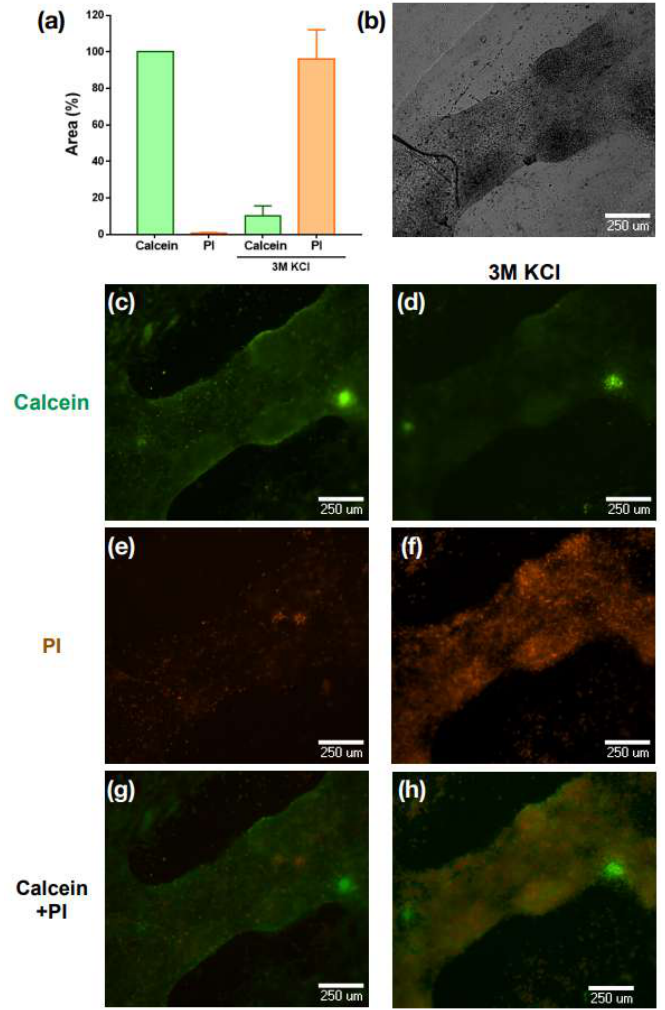
Figure 3. Viability and biocompatibility of PDMS microscaffolds and cardiac cells. ( a ) Graph of the percentage of live cell area vs. dead cells and after application of 3 M KCl, ( b ) monolayer micrograph of cardiomyocytes in brightfield. Live cardiomyocytes labeled with calcein after 24 hours of culture ( c ) and after being exposed to KCL 3 M ( d ). Dead cardiomyocytes labeled with propidium iodide after 24 hours of culture ( e ) and after being exposed to KCL 3 M ( f ). ( g ) and ( h ) are the superposition of (c and e) and (d and f), respectively.